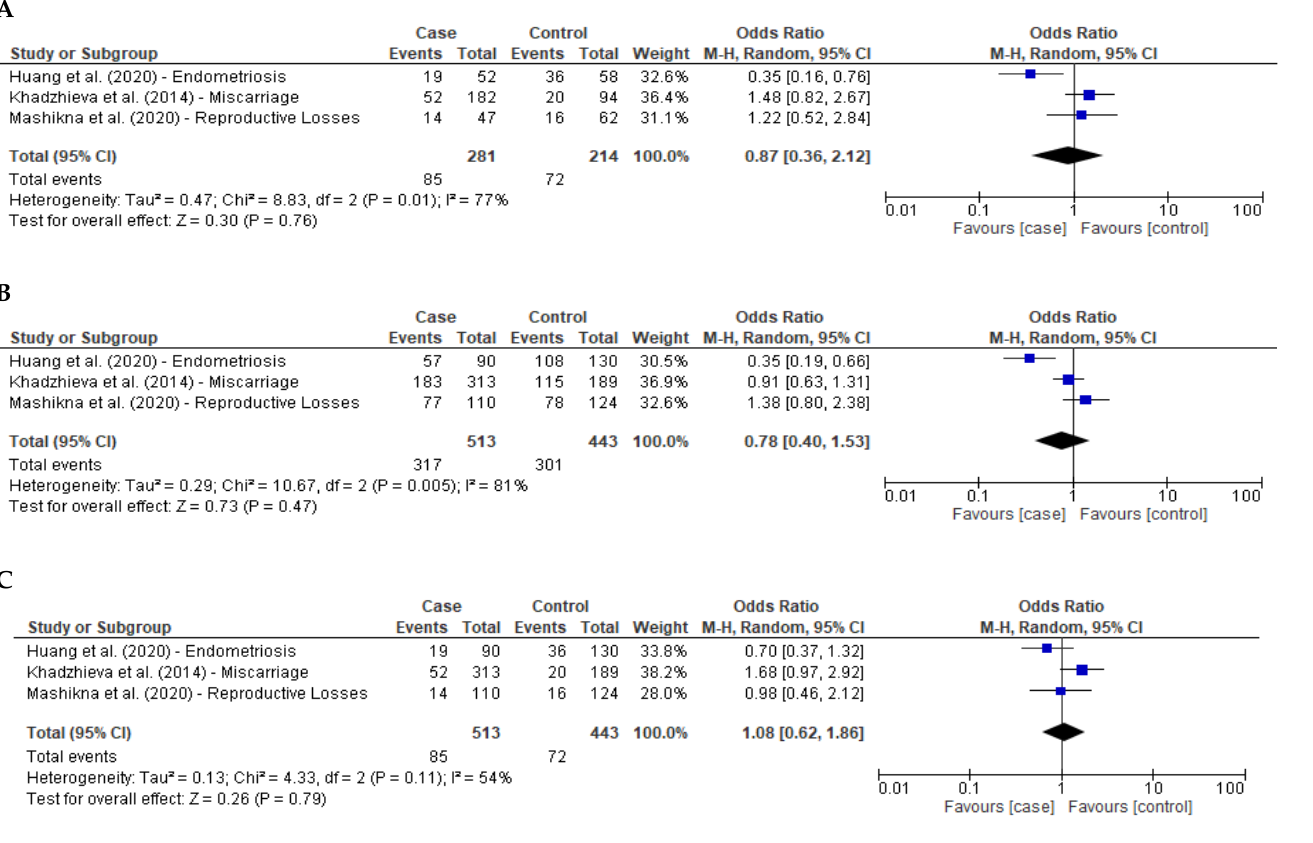
Figure 4. Forest plots of odds ratios with 95% confidence intervals of the association between GPX4 (rs713041) SNP and risk of reproduction-related diseases. ( A ) — Additive model (TT vs. CC) [22,42,43], ( B ) — Dominant model (CT+TT vs. CC) [22,42,43] and ( C ) — Recessive model (TT vs. ( B )—Dominant model (CT+TT vs. CC) [22,42,43] and ( C )—Recessive model (TT vs. CC+CT) CC+CT) [22,42,43].